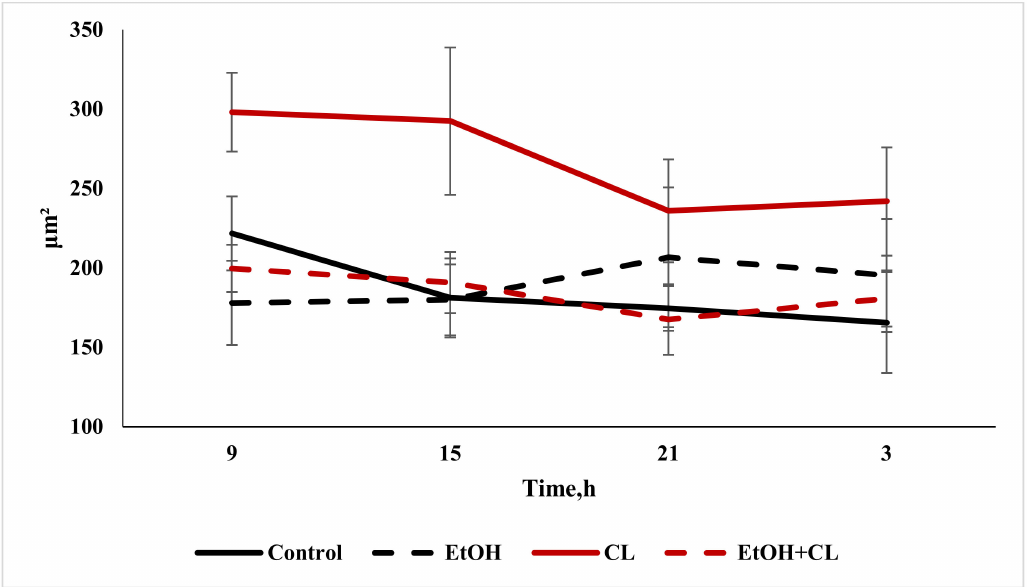
Figure 5. Daily dynamics of area of hepatocytes in rats.